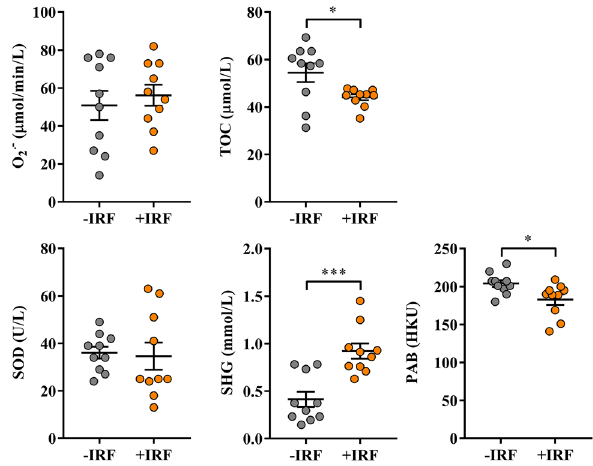
Figure 6. Influence of exposure to IR fibres on the redox status in sera from CIA-affected rats. Scatter plots show pro-oxidant parameters: superoxide anion radical (O2• − ) level and total oxidant capacity (TOC); antioxidant parameters: superoxide dismutase (SOD) activity, and sulfhydryl groups (SHG) level; and pro- oxidant-antioxidant balance (PAB) in sera from CIA rats housed in cages with IR fibre bedding (+IRF) and their counterparts housed in cages with standard wooden shaving bedding (−IRF rats). Of note, rats were transferred to cages with IR fibre bedding five days before immunization. Sera were obtained from CIA rats on the 22 nd day post immunisation. All graphs were created using GraphPad Prism version 7.00 for Windows, GraphPad Software, La Jolla, California, USA (https ://www.graph pad.com). Results are expressed as mean ± SEM. n = 10 rats/group. * p ≤ 0.05 and *** p ≤ 0.001.